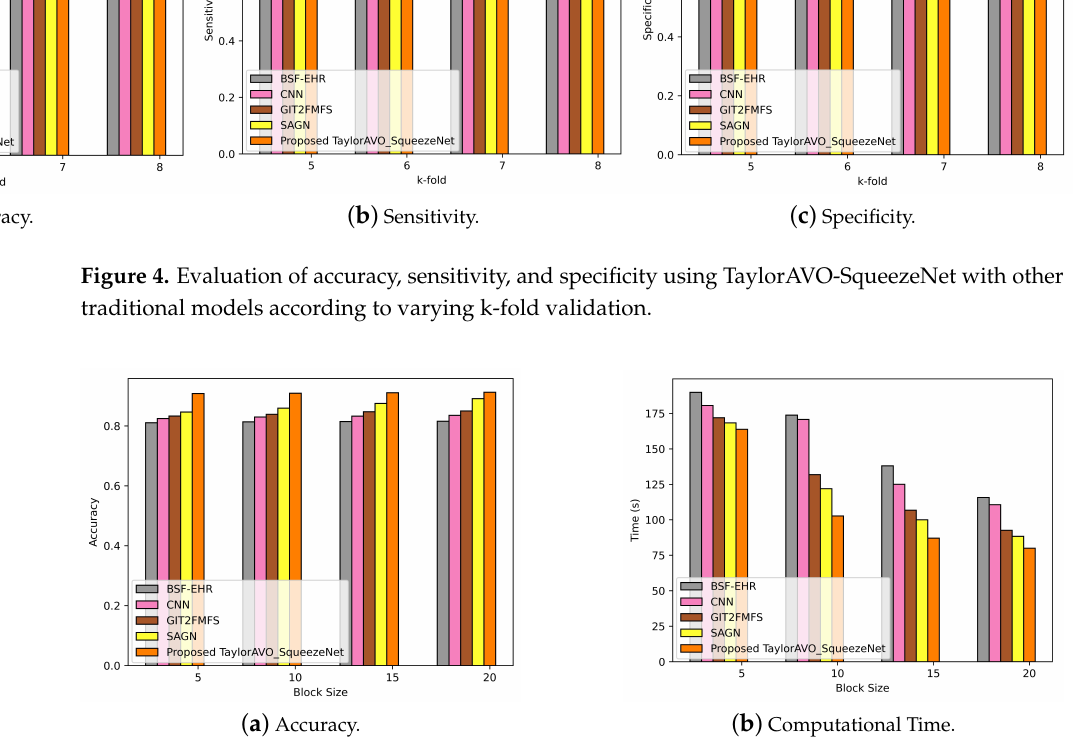
Figure 5. Evaluation of accuracy and computation time using TaylorAVO-SqueezeNet with other traditional models according to varying block size and